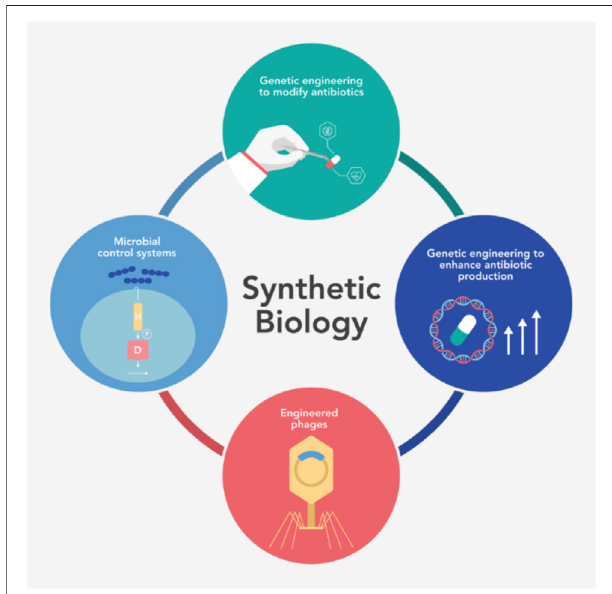
FIGURE 1 | Recent works have demonstrated the impact of synthetic biology and the tools and techniques that the fi eld has developed to allow genetically modifying antibiotics, enhancing antibiotic production, developing engineered phages, and designing microbial control